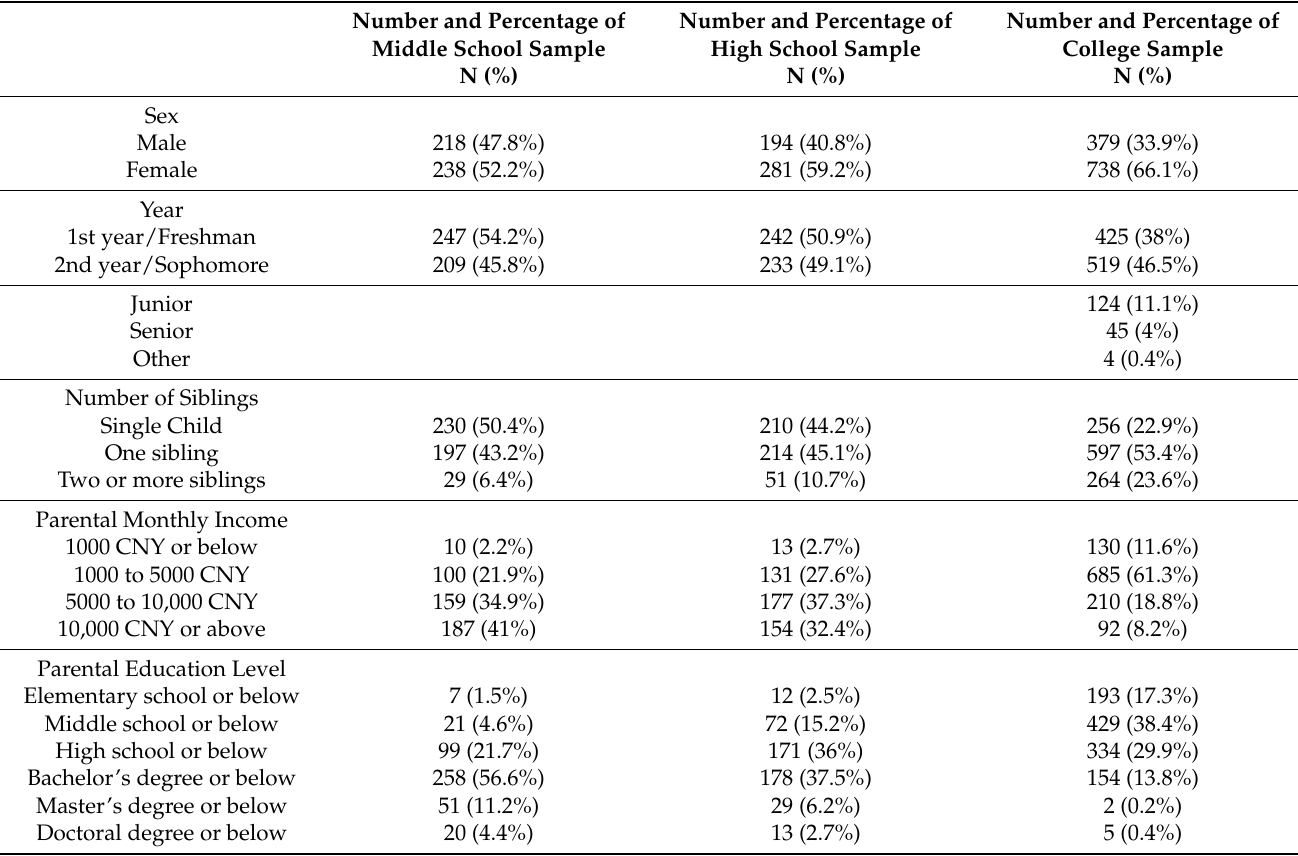
Table 1. Descriptive information of the three